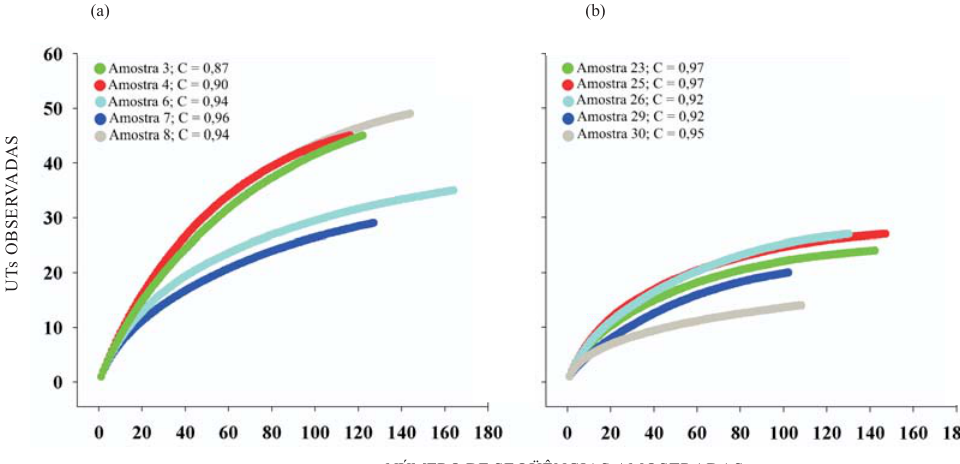
Figura 3. Curvas de extinção calculadas pelo programa DOTUR, usando 97 % de similaridade para o agrupamento das seqüências do gene nifH de 10 amostras coletadas nas regiões II (A) e V (B) do Rio Grande do Sul (C = representatividade da